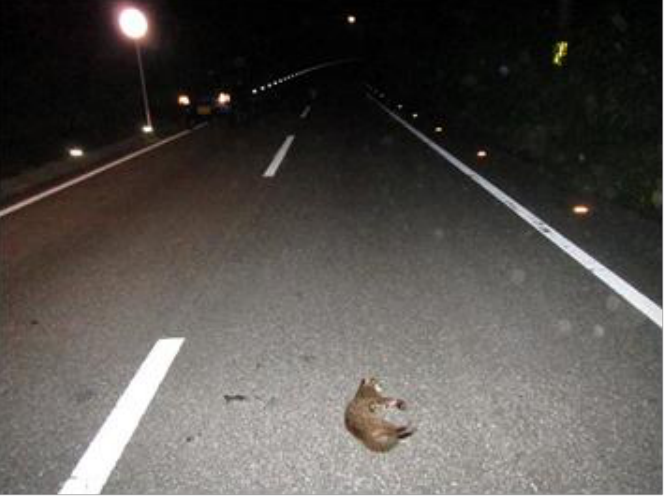
Figure 2. A picture of an Iriomote cat killed by an eco-tourist’s car; vehicles driven by eco-tourists have become a significant threat to the species. Photo by Makoto Fukuda, Iriomote Wildlife Conservation Center